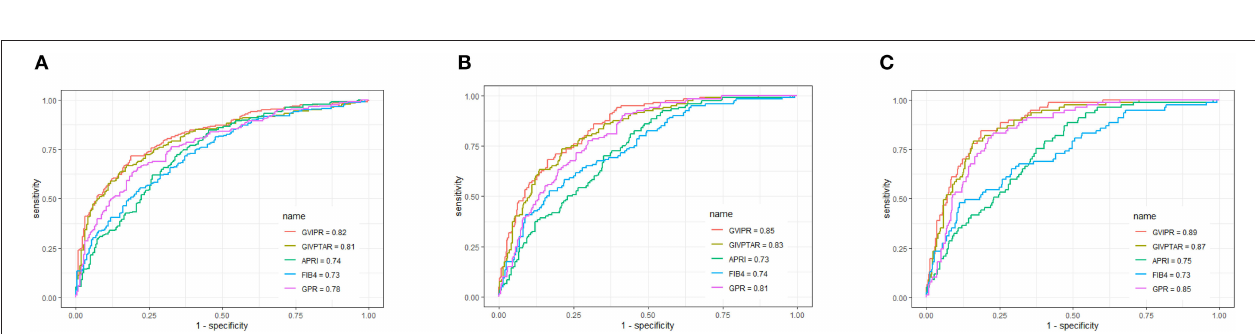
FIGURE 4 | Area under receiver operating characteristic (ROC) comparison of GIVPR, GIVPTAR, APRI, FIB-4, and GPR in validation set. (A) ROC comparison for predicting significant fibrosis; (B) ROC comparison for predicting advanced fibrosis; (C) ROC comparison for predicting cirrhosis.